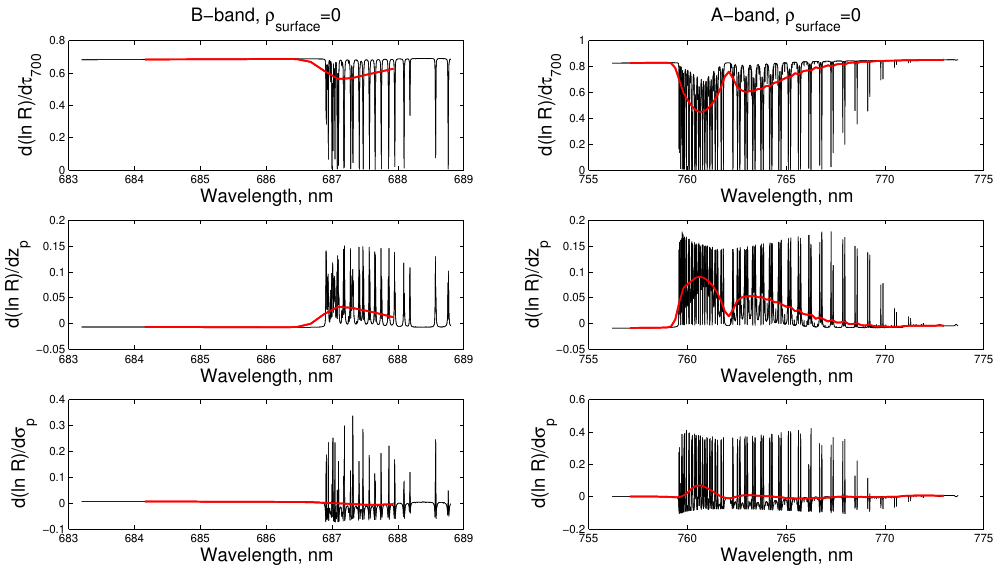
Fig. 1. A representation of the Jacobian matrix for a black surface. The spectra shown in black are computed at a fine resolution of 0.002nm. The red curves are computed for the SCIAMACHY wavelength grid after convolution of the high resolution spectrum with a gaussian slit function having a FWHM of ≈ 0.4nm. The top panels show the column of the Jacobian matrix corresponding to differentiation with respect to the aerosol optical thickness, τ 700 . The middle and bottom panels represent derivatives with respect to the peak height z p and the peak width σ p , respectively. The Jacobians have been calculated at τ 700 =1.0, z p =3km and σ p =0.7 for a biomass aerosol. The viewing geometry is statistically representative for SCIAMACHY observations over Kanpur with SZA=43 ◦ , LZA=11 ◦ , Relative Azimuth=149 ◦ . In each case, the left panel represents the B-band, while the right panel represents the